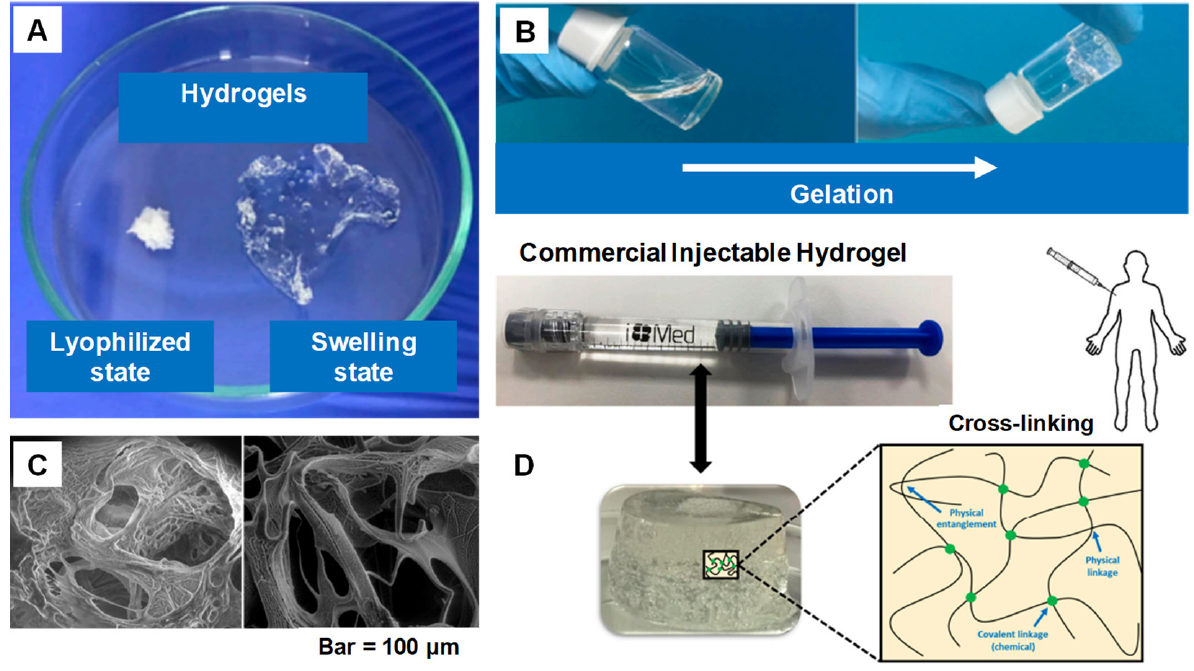
Figure 1. ( A ) Swelling ability of hydrogels from lyophilized state. ( B ) Example of a gelation time measurement by inverted vial method. ( C ) Cross-section SEM images of freeze-dried injectable hyaluronic acid hydrogel. ( D ) Physical interactions and chemical linkages of the chemical structure of an injectable hydrogel. Adapted with permission from ref. [9]. Copyright © 2021 Polymer MDPI.